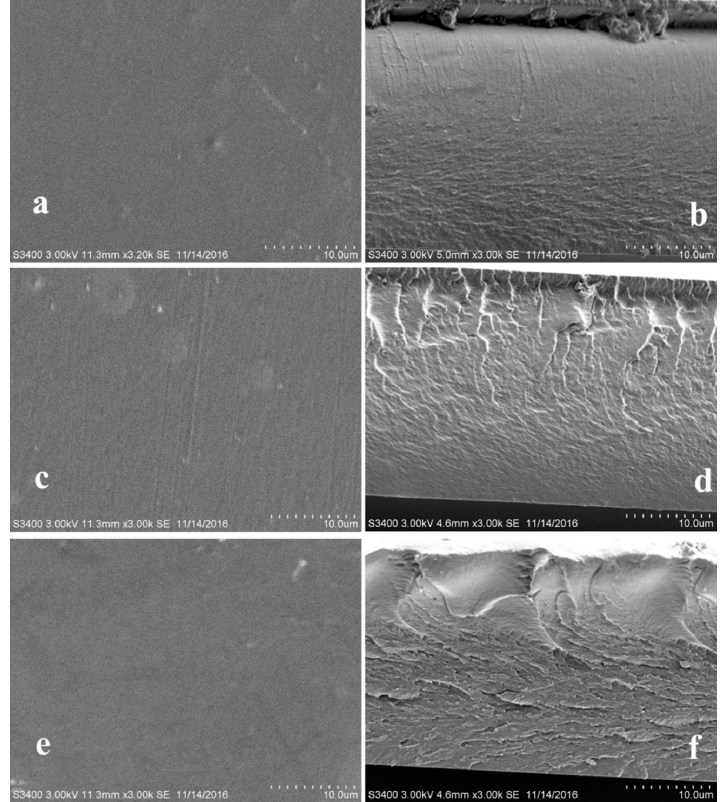
Figure 3. Scanning electron microscope (SEM) images of representative composite films prepared